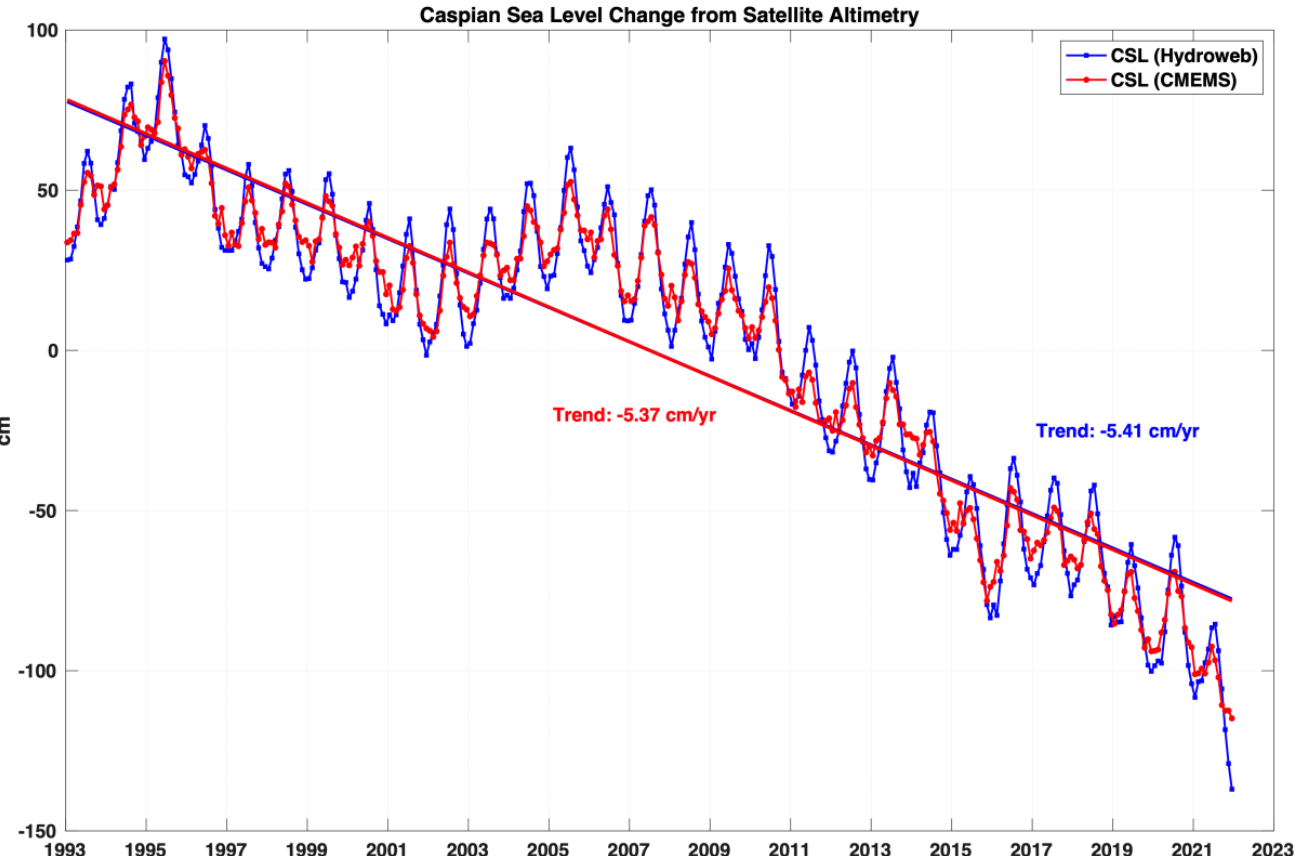
Figure 2. Monthly Caspian Sea level changes (in units of cm) observed by satellite altimeter over the period of January 1993 to December 2021, provided by the Hydroweb project (https://hydroweb.theia-land.fr/; Accessed on October 24 2022) and estimated from the CMEMS global SLA product (https://data.marine.copernicus.eu/; Accessed on July 27 2022). The two lines (red and blue) represent the linear trends estimated from least-squares fit (the two lines are mostly overlapped with each other, as the estimated trends are too close). The estimated trends, − 5.36 cm/yr and − 5.41 cm/yr are labeled in the plot with corresponding colors.